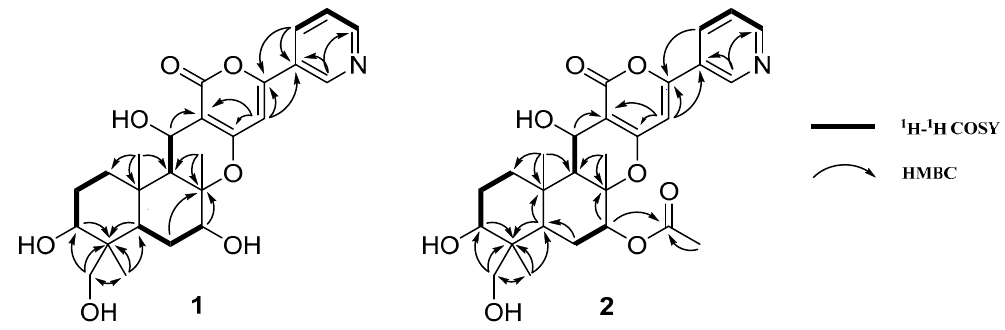
Figure 2. Key 1 H ‐ 1 H COSY and HMBC correlations in 1 and 2 . Figure 2. Key 1 H- 1 H COSY and HMBC correlations in 1 and 2